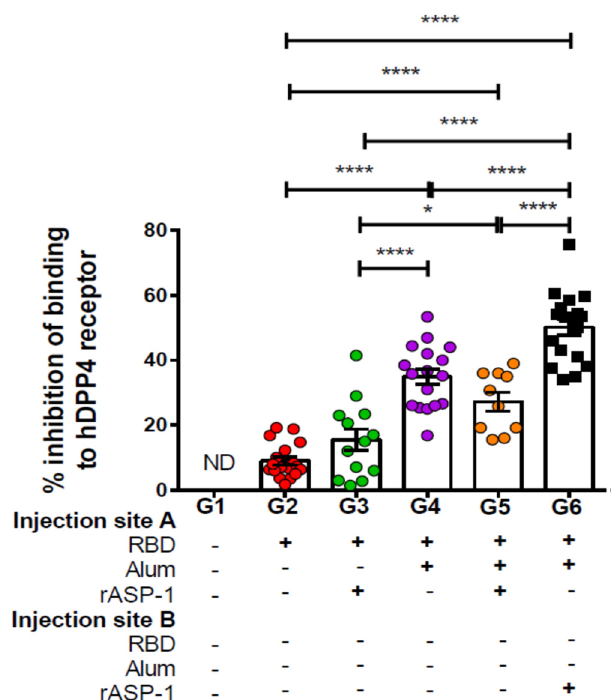
Figure 2. Inhibition of binding of Middle East Respiratory Syndrome Coronavirus (MERS-CoV) RBD-Fc to hDPP4 receptor by sera of immunized mice: C57BL / 6 mice were immunized i.m. with MERS-RBD-Fd with or without alum and rASP-1 alone or together using di ff erent combinations and / or formulations (Table 1 and X-axis legend). Sera samples were collected on day 7 post-2nd immunization and assayed for inhibition of the binding of MERS-CoV RBD-Fc to Huh-7 cells expressing MERS-CoV receptor DPP4. The data represents the mean and standard error (SEM) of percentage inhibition of binding from at least two independent experiments with 3 to 5 mice per group. “ + ” indicates the presence and “ − “ indicates the absence of the protein or adjuvants in the formulation. Statistics was performed using one-way ANOVA with Tukey’s multiple comparison. p < 0.05: *, p < 0.0001: ****. ND: not